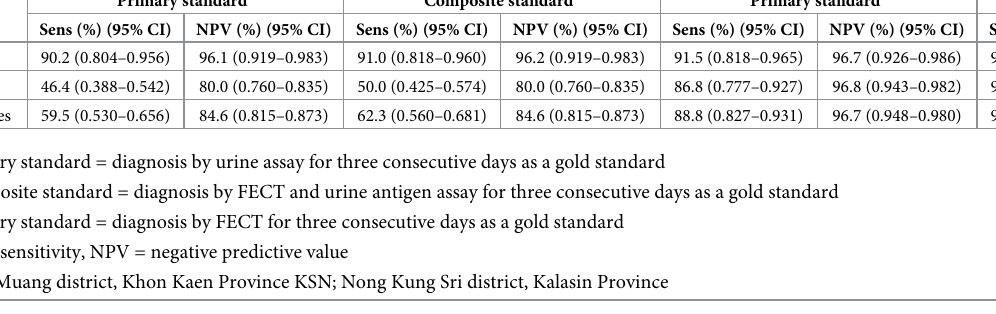
Table 2. Performance statistics for fecal examination by FECT and urine assay for diagnosis of opisthorchiasis with reference to primary or composite reference standards. Locality